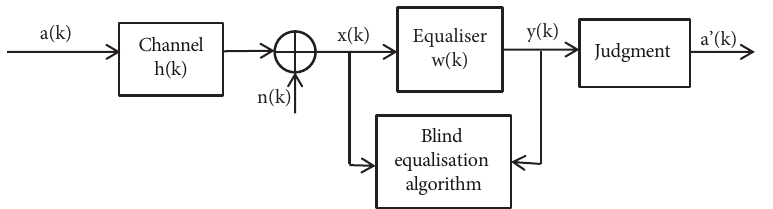
Figure 1: Schematic diagram of blind equalisation